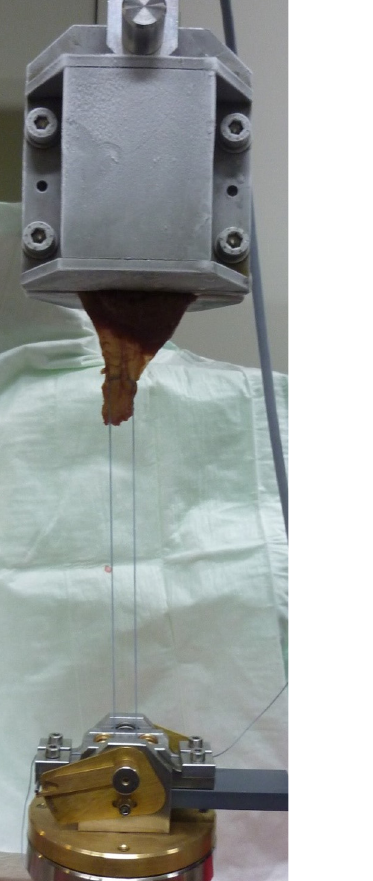
Figure 3: Part of the Zwick UTM test setup. DLKS is shown. The infraspinatus muscle is clamped using two metal brackets of a cryo - jaw ( upper part of the picture ) . The compensator device is mounted on the UTM base ( lower part of the picture )